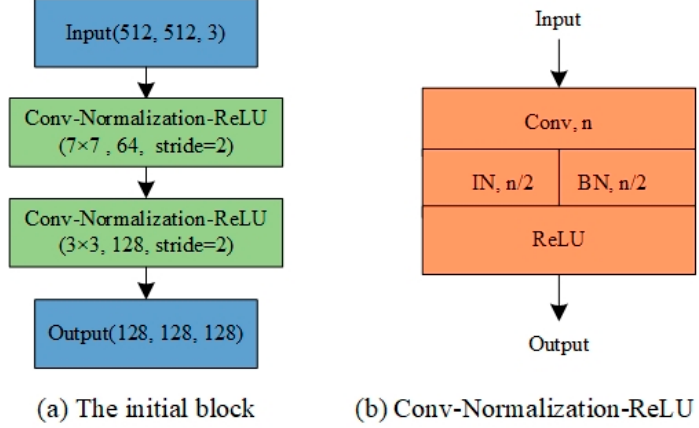
Figure 4. The initial block of our proposed network. ( a ) Overall structure of the initial block, in which the size, number, and step size of the convolution kernel are annotated. ( b ) The specific structure of Conv-Normalization-ReLU block, n is the number of convolution kernels.